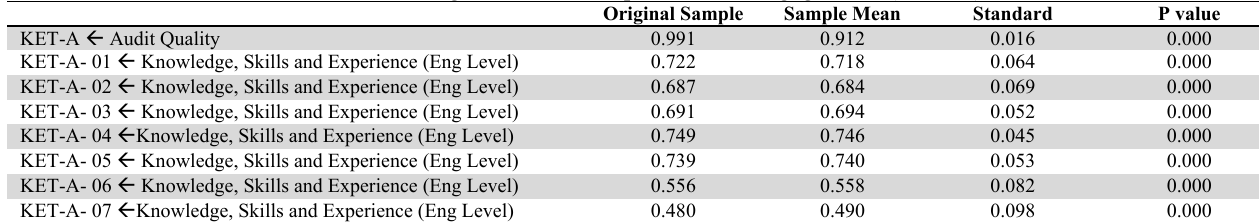
The Manifestation of Attributes of Knowledge, Skills, and Experience for Engagement (Auditor) Level